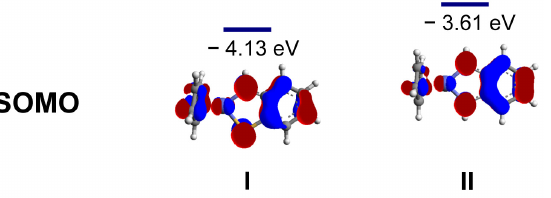
Figure 6. SOMO and corresponding energies of compounds I and II in their anionic reduced form.